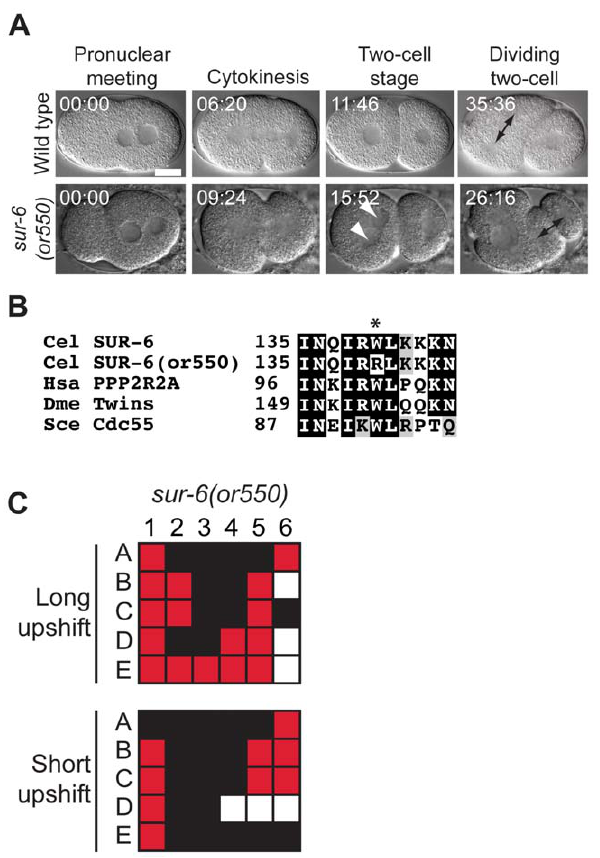
Figure 2. A sur-6 mutant. A. DIC time-lapse images of wild-type and sur-6(or550 ts ) embryos. In the sur-6 mutant the male pronucleus is small, the AB cell contains two nuclei, and the P 1 cell begins mitosis before the AB cell. The sur-6(or550 ts ) embryo was shifted to the restrictive temperature for , 1 min. prior to imaging. White arrowheads denote multiple nuclei per cell, and the arrows in the last panels indicate the first mitotic spindle at the two cell stage. Times in min:sec are given relative to pronuclear meeting. Scale bar, 10 m m. B. Amino acid alteration in the mutant. Asterisk indicates the changed residue. Homologous proteins are aligned below the C. elegans protein. C. Defect maps for individual embryos observed during time-lapse recordings. In this and all subsequent figures, embryos are listed on the left and phenotypes are listed on the top: 1; Male pronuleus normal size, 2; Nuclear centrosomal complex centration, 3; spindle alignment, 4; successful cytokinesis, 5; one nucleus per cell at two cell stage, 6; AB divides first at two cell stage. In the long upshifts, hermaphrodites were transferred to the restrictive temperature for 5–8 hours. In the short upshifts, embryos were harvested from hermaphrodites grown at 15 u C and immediately mounted on agar pads for imaging, which took , 1 min. In this and all subsequent figures, red color indicates a defective trait, black color represents the lack of a defect, and white indicates that the trait was not visible in the recording.